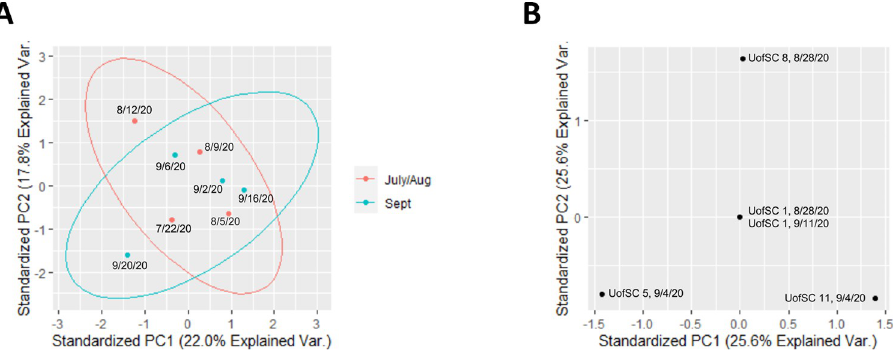
Fig 4. Principal Component Analysis (PCA) of (A) Columbia WWTP influent composite genotypes (from July- September, and (B) University of South Carolina wastewater composite genotypes. Composite genotypes for each wastewater sample were established by calculating the nucleotide frequency at each position in the SARS-CoV-2 reference genome. The composite genotypes were then pairwise compared to each other by summing of the Yue and Clayton similarity index [23] for each position in the reference genome. Analysis and visualization were performed with the R packages prcomp and ggbiplots. The size of the ellipse in Normal probability (ellipse.prob option) was set to